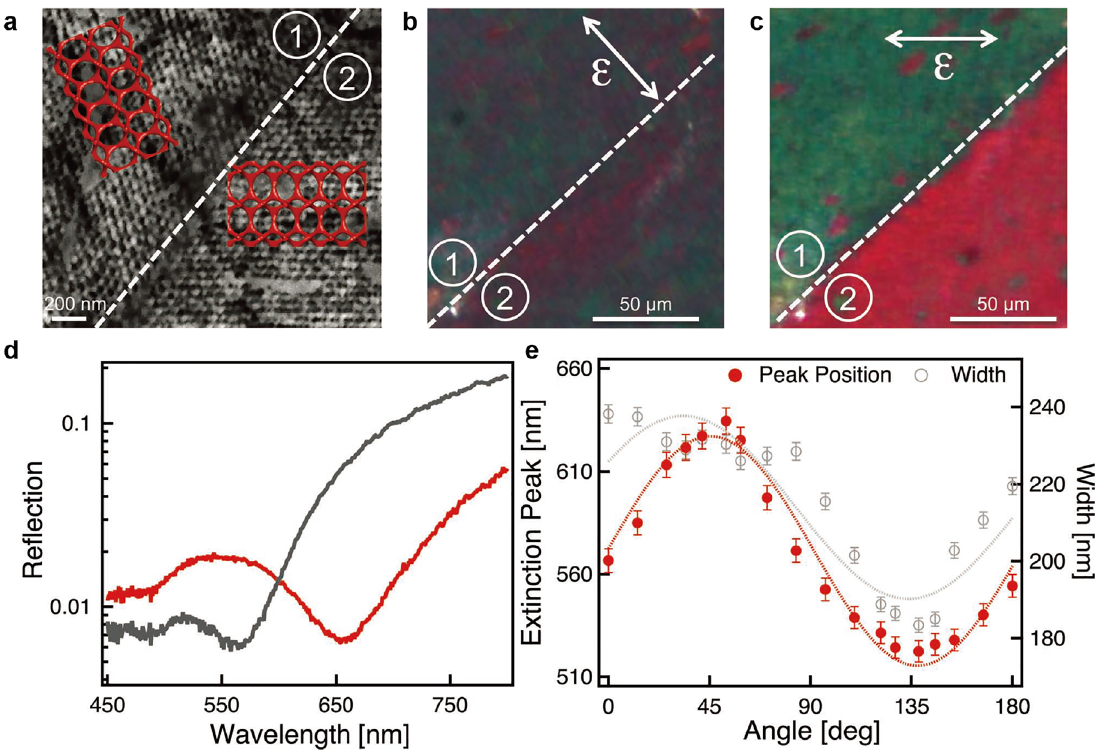
Figure 6: Linear dichroism of single Au-gyroid structure. (a) Scanning electron microscope (SEM) image of single Au gyroid domains with grain boundary line. (b) and (c) Opical reflection images in responsestoincidentpolarizedlights(b)perpendiculartothelineand(c)parallelto[100]gyroiddirection.(d)Re fl ectancespectraofAu-gyroid structure located at area ① , wherein polarized lights are perpendicular (red) and parallel (gray) to the [100] gyroid direction. (e) Extinction peak position and width as a function of angle between [100] gyroid direction and polarized lights. Reproduced with permission from ref. [3]. Copyright 2011, Wiley-VCH Verlag GmbH Weinheim (a) –